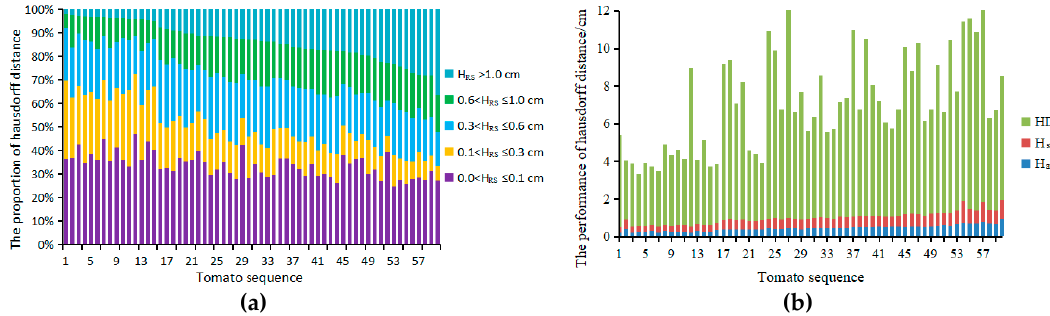
( h ) Figure 5. Results of the 3D point cloud reconstruction of a plant with different reconstruction methods: ( a ) V3-1; ( b ) V3-2; ( c ) V3-3; ( d ) V3-4; ( e ) V4-1; ( f ) V4-2; ( g ) V4-3; ( h ) depth map. 3.2. Accuracy Analysis of Point Cloud Reconstruction of the GTPs To quantitatively describe the accuracy of 3D point cloud reconstruction of the GTPs, the distribution of the H RS set of each of the 60 GTPs was statistically analyzed. Figure 6 shows the distribution